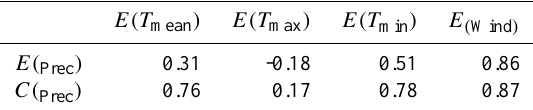
Table 4. Correlations of model performance between the precipita- tion and the mean/maximum/minimum 2-m temperature and 10-m wind speed. The correlation coefficients are calculated on the basis of skill scores for the precipitation (based on E and C , respectively) and for the temperature and wind speed (based on E) of the 148 simulations (25-km) over SGP.